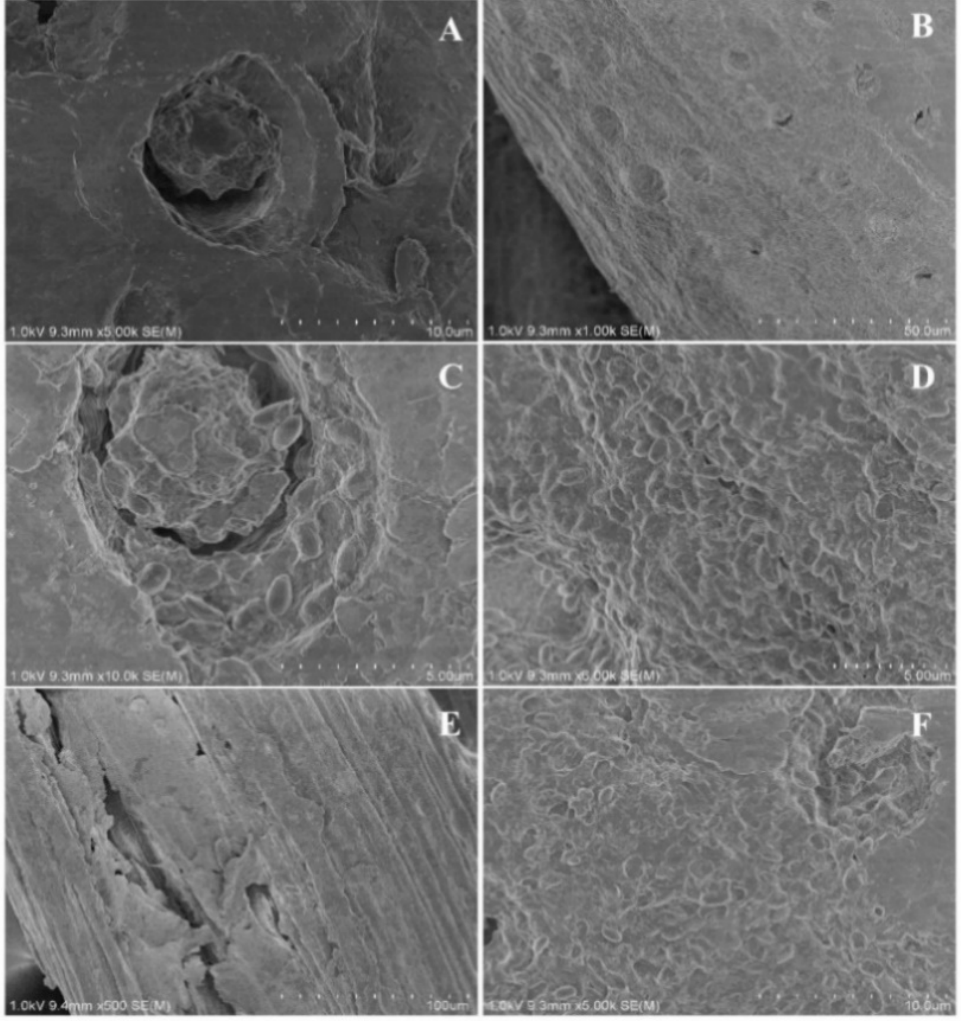
Figure 1. SEM images of different matrices ( Page: 3A , B ) initial palm curtain with magnifications of × 5000 and × 1000, respectively; ( Page: 3C , D ) Bacillus circulans ATCC 21783 immobilized on palm curtain with magnifications of × 10,000 and × 5000, respectively; ( E ) initial loofa sponge with magnification of × 500; ( F ) Bacillus circulans ATCC 21783 immobilized on loofa sponge with magnification of × 5000.